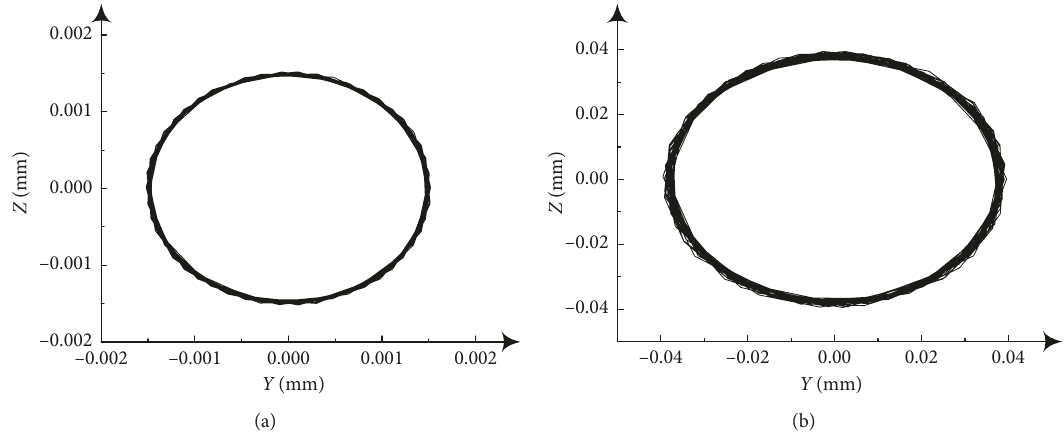
Figure 11: Relative tracks at (a) T � 100K and (b) T � 200K.